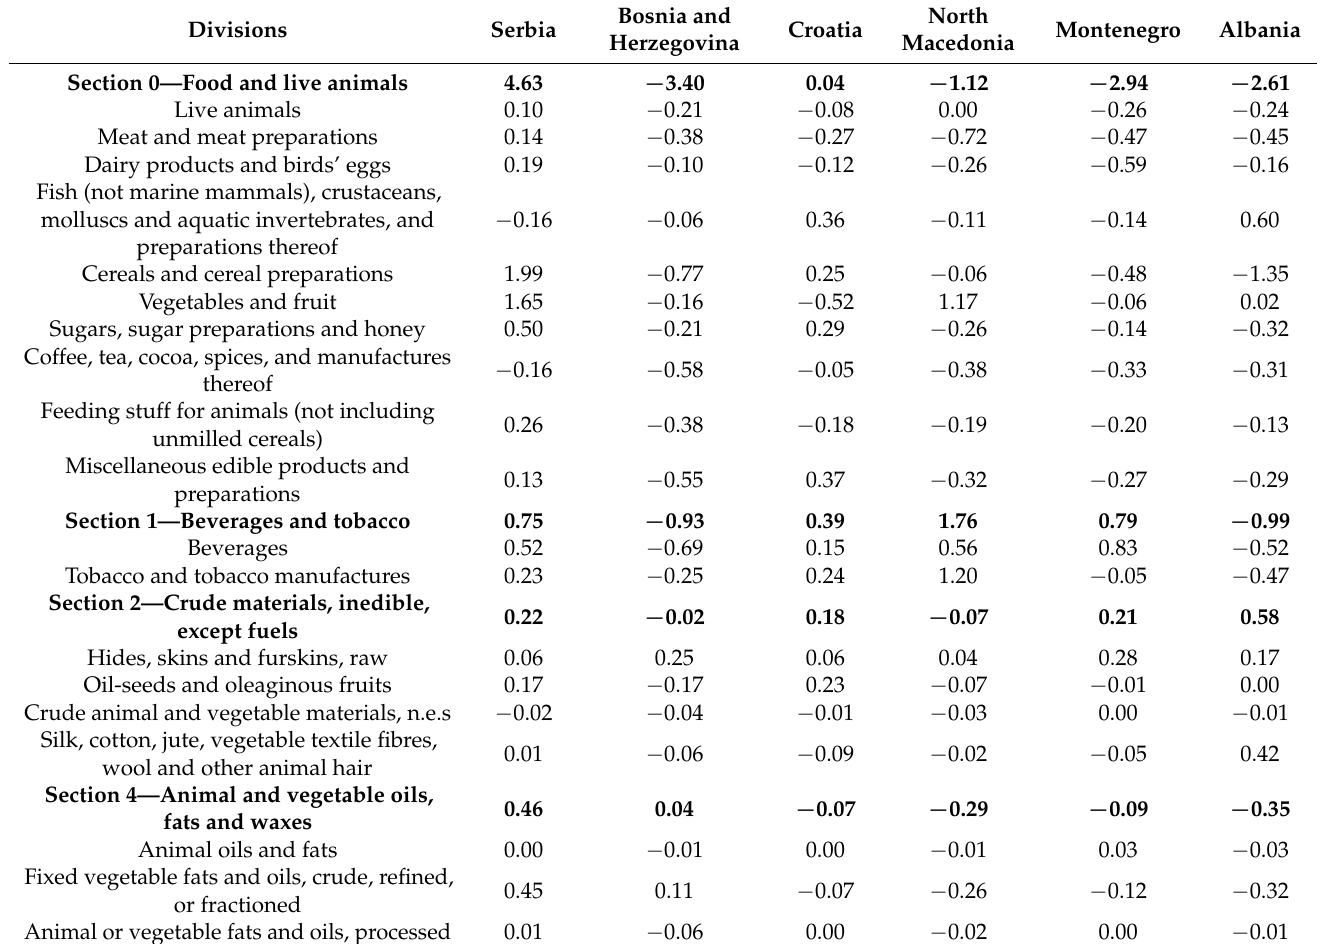
Table 3. Index of revealed comparative advantages of divisions of agri-food sector of the WB